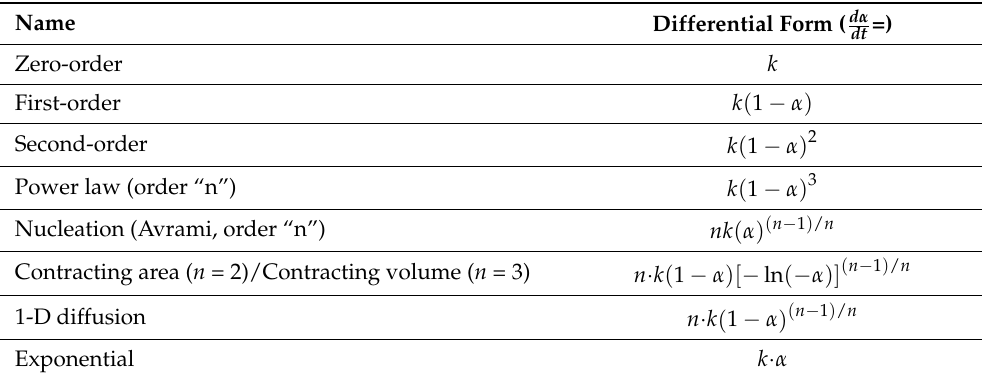
Table 4. Main kinetic models for degradation processes. Modified from: